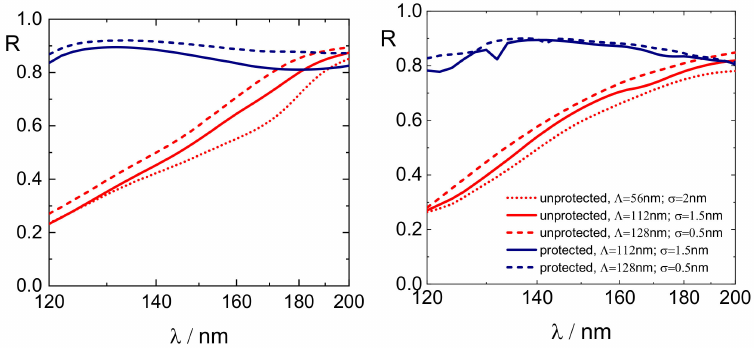
Figure 10. Left: measured VUV-spectra; right: selected calculated